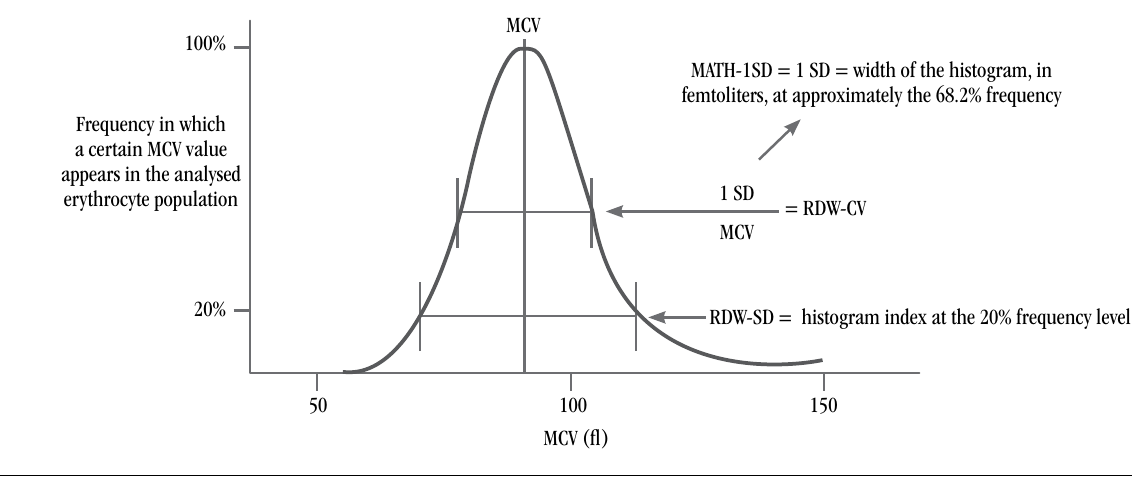
figurE – Obtainment of RDW-CV, MATH-1SD and RDW-SD from erythrocyte volume distribution histogram (1 SD) RDW-CV: coefficient of variation of red cell distribution width; RDW-SD: standard deviation of red cell distribution width; SD: standard deviation; MCV: mean corpuscular volume.